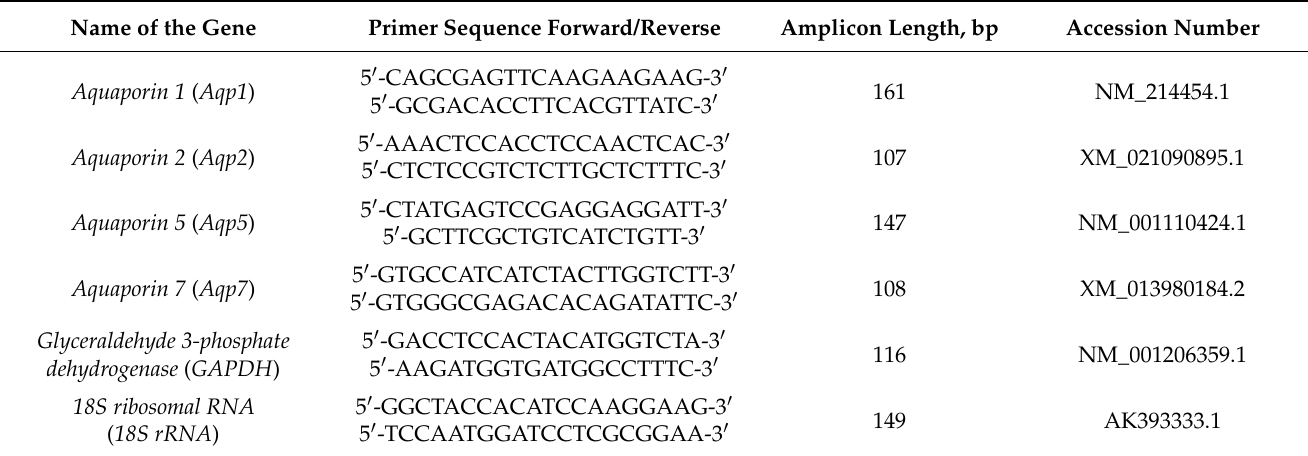
Table 2. Forward and reverse primers sequences, amplicons length, and GeneBank accession numbers of genes used during real-time PCR